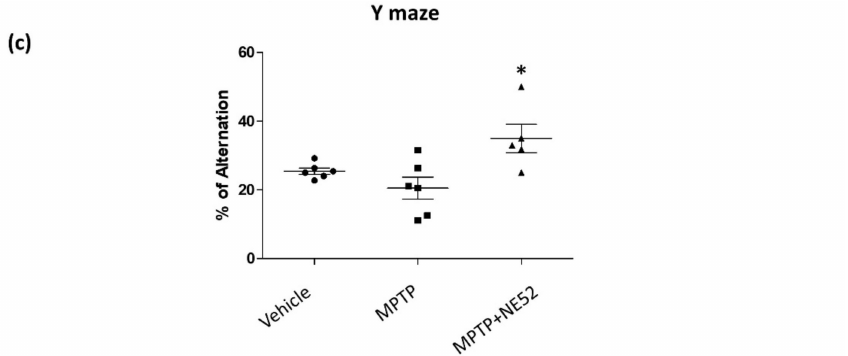
Figure 6. GPR4 inhibition attenuates motor deficits in a subchronic MPTP-treated mouse model of PD. MPTP was administered (30 mg/kg/day) for 5 days. Behavioral experiments were performed three days after the final MPTP administration ( a ) PD-like bradykinesia was measured using a pole test. ( b ) Motor coordination function was measured using a Rotarod test. Both the fall latency and the distance travelled were measured. ( c ) Spatial memory measured using Y-maze. Each dot represents the average of five individual trials, and the thick bar represents the mean ± standard deviation. Data represented as mean ± SEM ( n = 5 of triplicates). One-way ANOVA, followed by Tukey’s multiple comparison test, was used to compare differences between groups. # p < 0.05 when the MPTP-treated group is compared with the vehicle-only group; * p < 0.05 other treated groups compared with the MPTP-treated